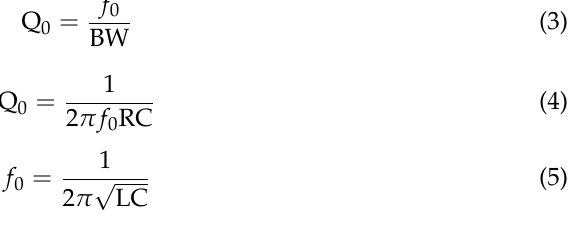
Table 1. Calculated values of lumped elements.